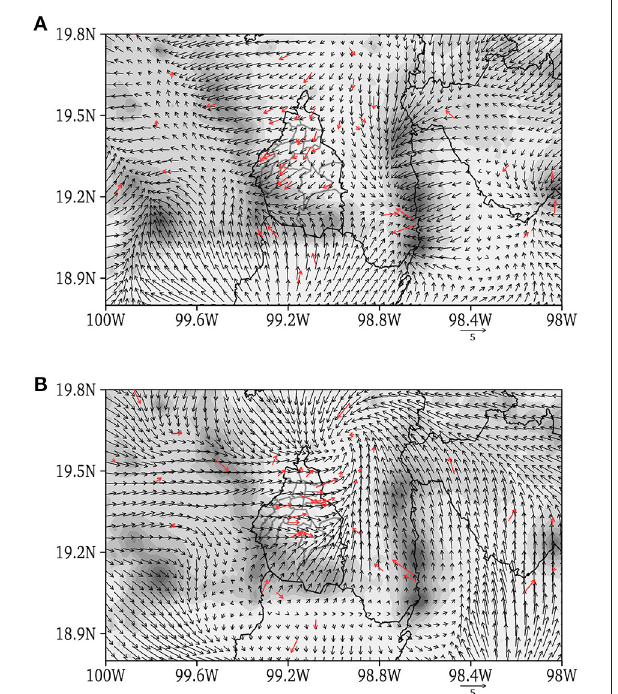
FIGURE 8 | 10m wind field (m/s) from the modified WRF version; vectors in red correspond to observations at surface stations: (A) 18:00 UTC 31 July 2014 morning valley mountain circulation; and (B) 02:00 UTC 1 August 2014 mountain–valley evening circulation.